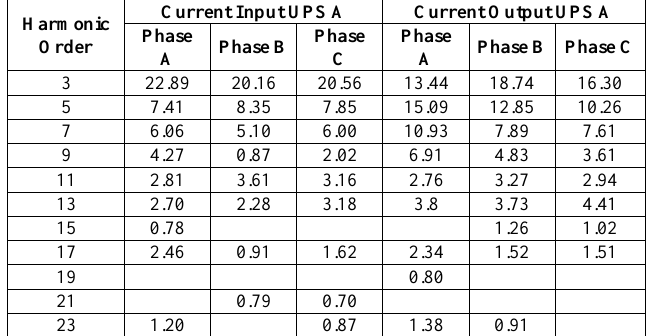
Table 2: Comparison of the current of UPS A. Harmonic Order